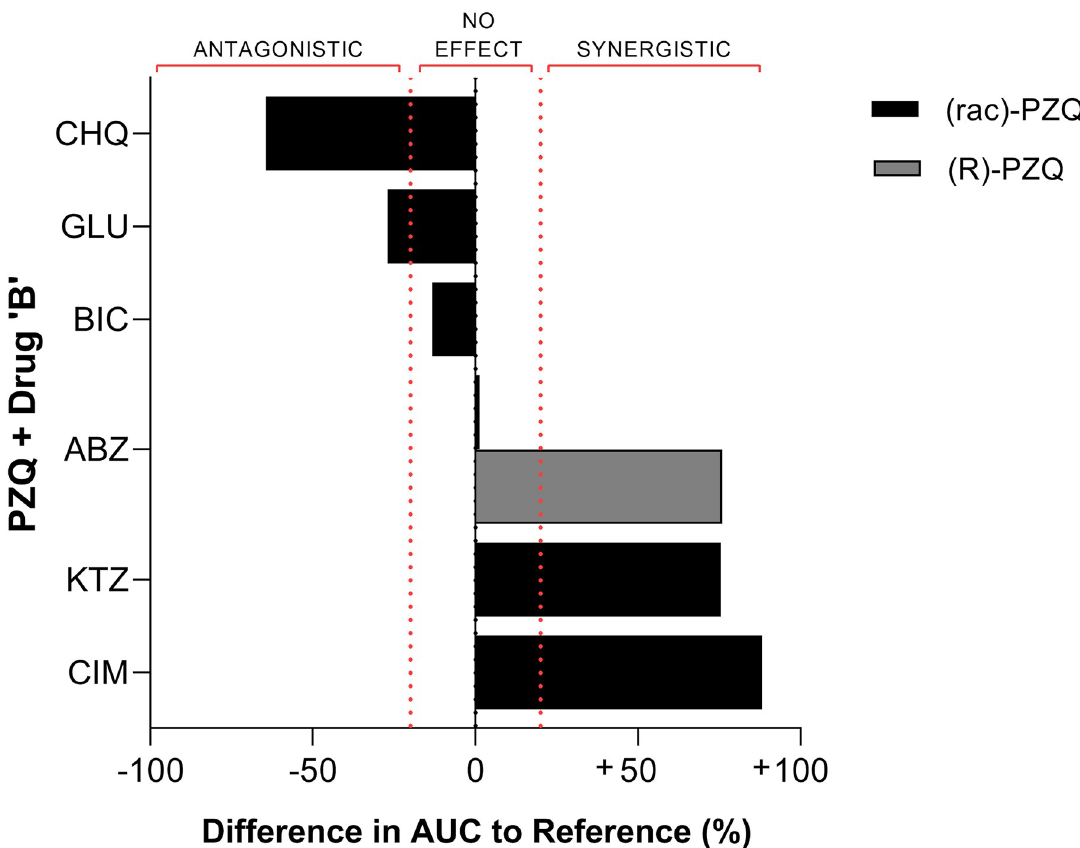
Fig 6. A summary of the human DDIs. Each bar represents the percentage change in AUC during the drug combination in comparison to PZQ alone. The effect of the drug combination is listed above the bar chart, with ± 20% representing the boundaries of no effect due to interindividual variation [87]. The data were extracted from five papers [54, 59, 84–86], compiled in S10 Table, analysed to create percentage change in AUC and then plotted to aid further analysis. ABZ, albendazole; AUC, area under the curve; BIC, bicarbonate; CHQ, chloroquine; CIM, cimetidine; DDI, drug–drug interaction; GLUC, glucose; KTZ, ketoconazole; PZQ,